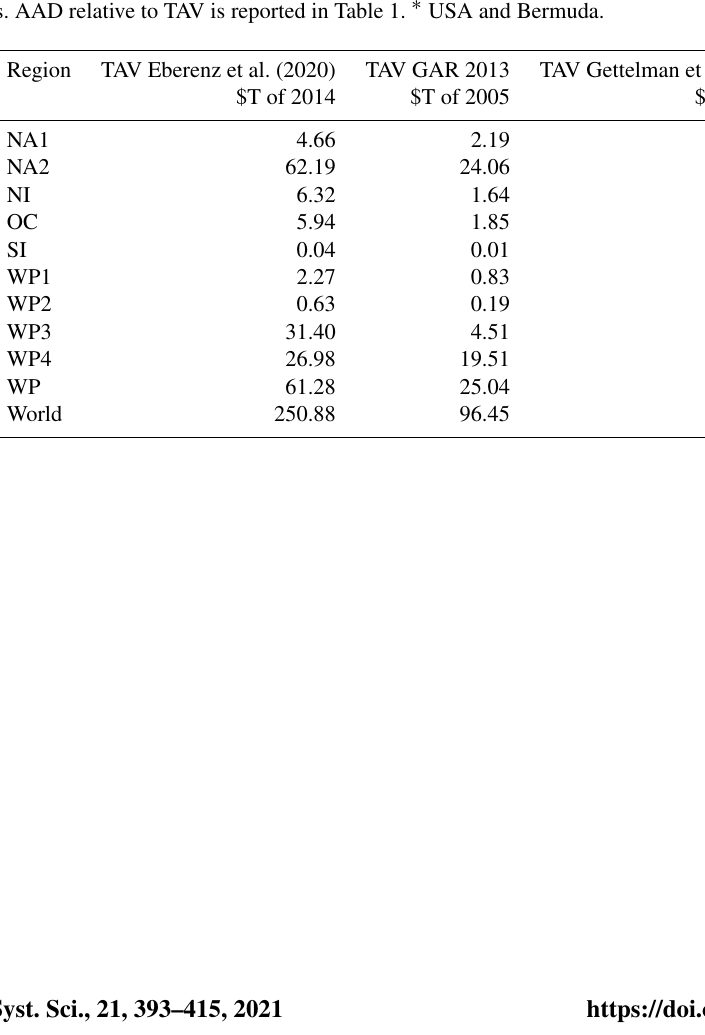
Table A3. Total asset exposure values (TAVs) per region. First column: TAV based on Eberenz et al. (2020) as used in this study. Second and third columns: reference values of TAV from GAR 2013 and Gettelman et al. (2017). The unit is 10 12 US dollars ($T) valued according to the year noted in brackets. AAD relative to TAV is reported in Table 1. ∗ USA and